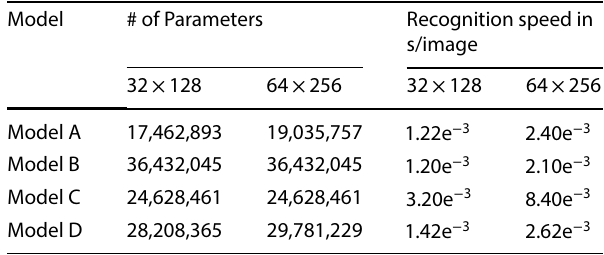
Table 5 Average recognition speed and number of trainable parameters of different recognition models used in this